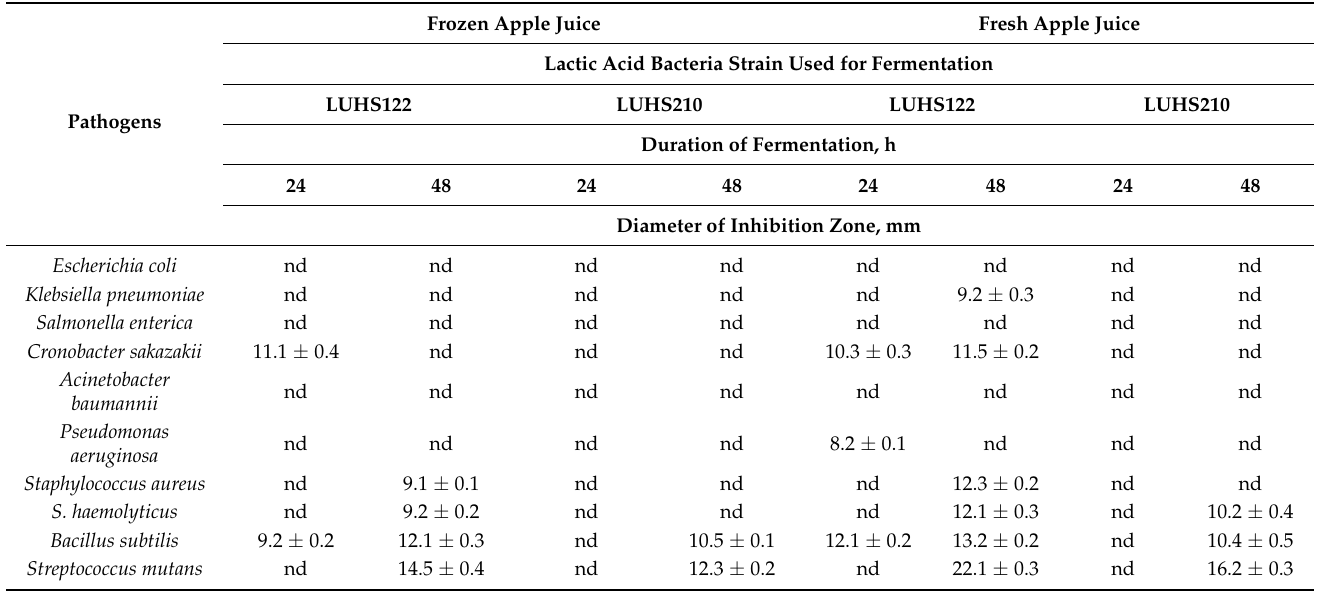
Table 8. Antimicrobial activity of fermented apple juice samples against opportunistic pathogenic microorganisms.